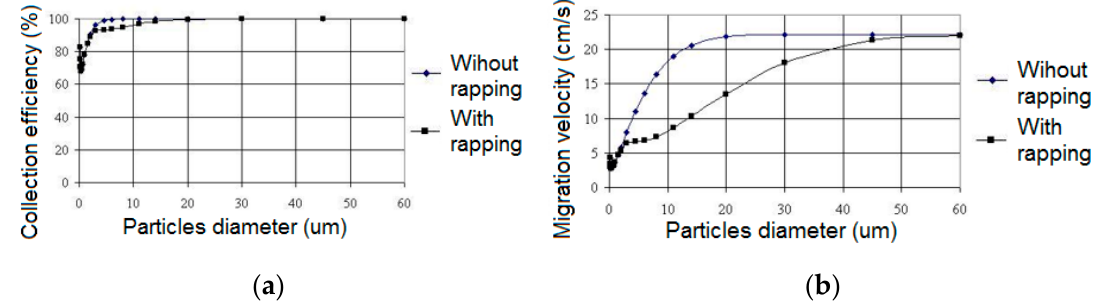
Figure 13. ( a ) The collection efficiency depends on the diameter of the dust particles. ( b ) The migration velocity depends on the diameter of the dust particles, without and with rapping, with the thickness of the dust layer: 5 mm in Section 1, 3 mm in Section 2, and 1 mm in Section 3, with an average diameter of 5 µ m.